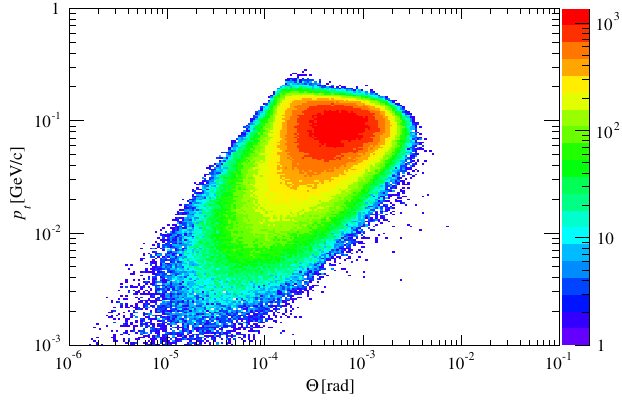
FIG. 12. Same as Fig. 11 but for opposite-charge (focused) particles.